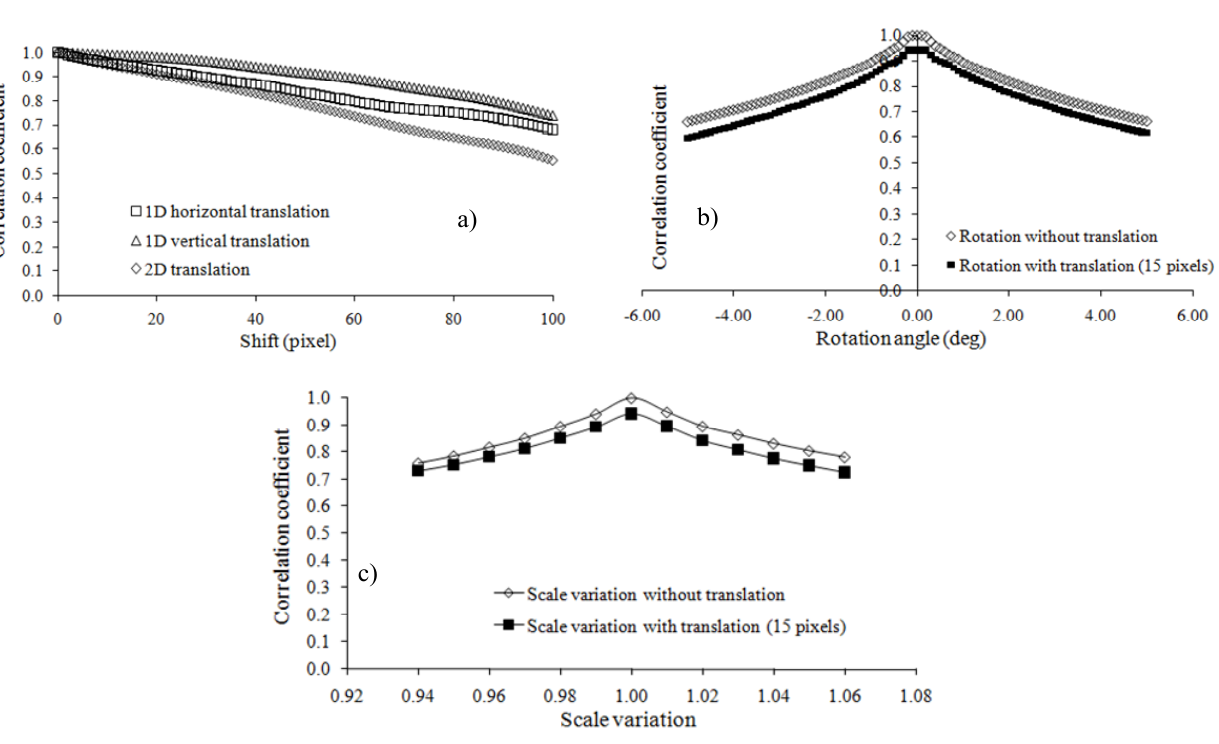
Figure 6. Effects of the extent of overlap between image pairs on the correlation